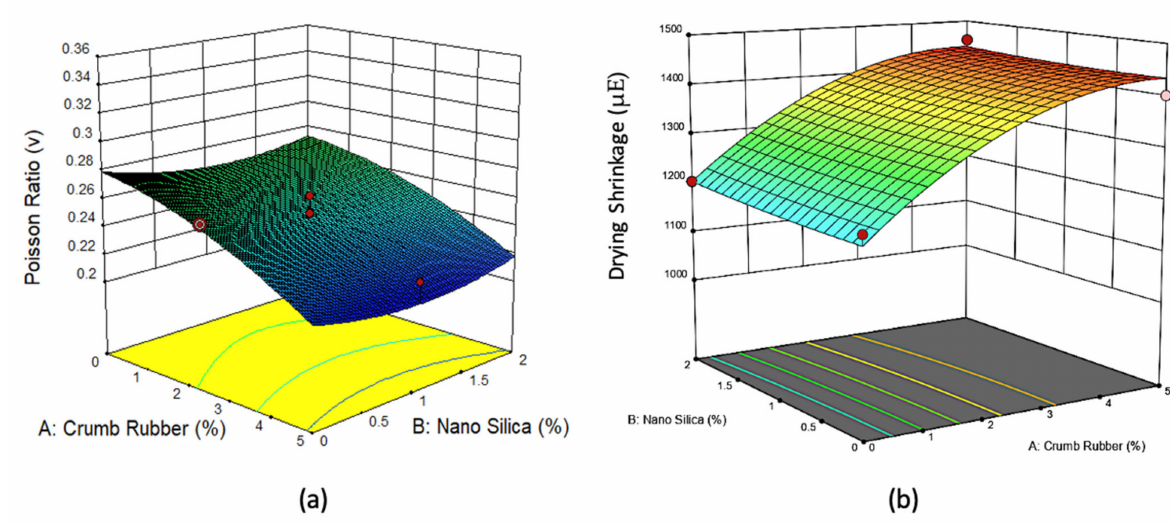
Figure 8. The 3D response surface plot for 50% fly ash and 2% PVA fiber for ( a ) Poisson’s ratio and ( b ) drying shrinkage.